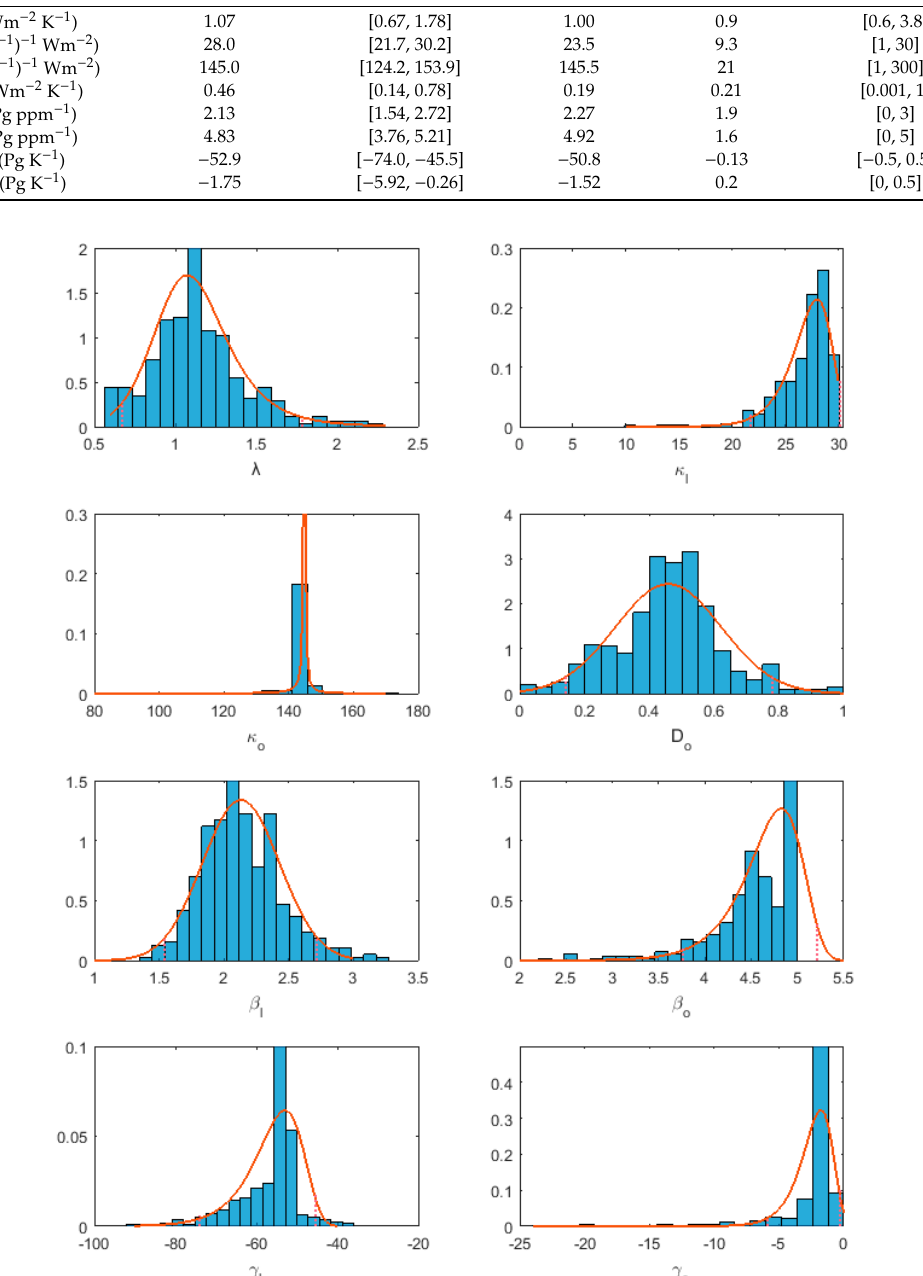
Figure 4. Parameter distributions by random input of emission and temperature.